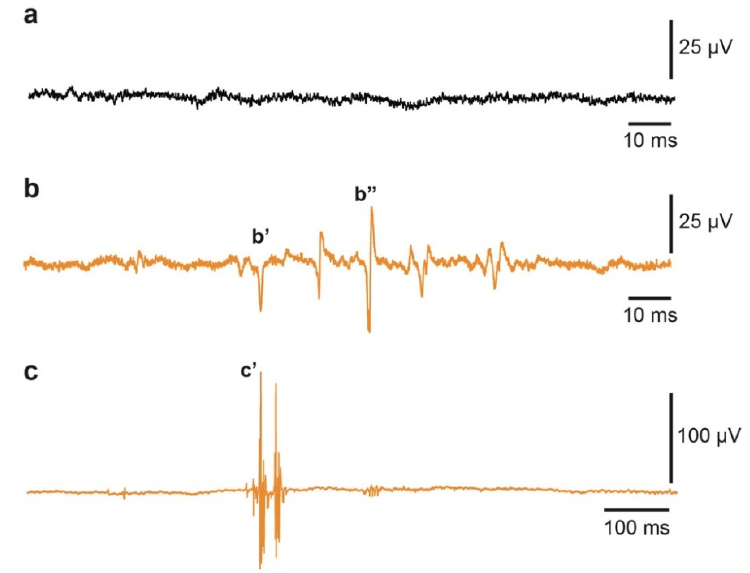
Figure 2. Abnormal spontaneous activity in CTB-Sap-induced acute GM denervation. ( a ) EMG recording of spontaneous activity in HC left GM at 42 dpl; ( b ) positive sharp waves ( b’ ) and fibrillation ( b” ) in CTB-Sap left GM at 42 dpl; ( c ) multiplet motor unit neuromyotonic discharges ( c’ ) and irregular bursts of discharges in denervated GM.